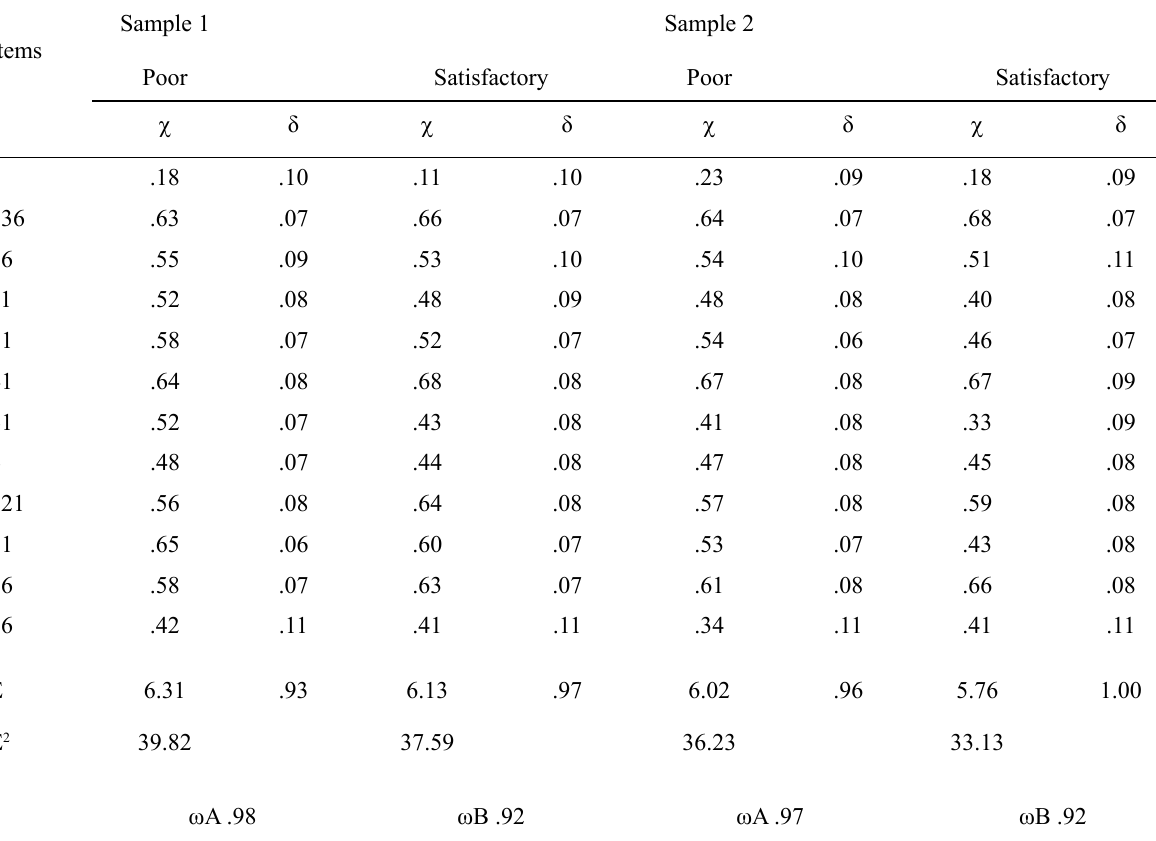
Completely Standardized MLE Parameter Estimates for Poor and Satisfactory Fitting Single-Factor Models: Neuroticism Sample 1 Sample 2 Items Poor